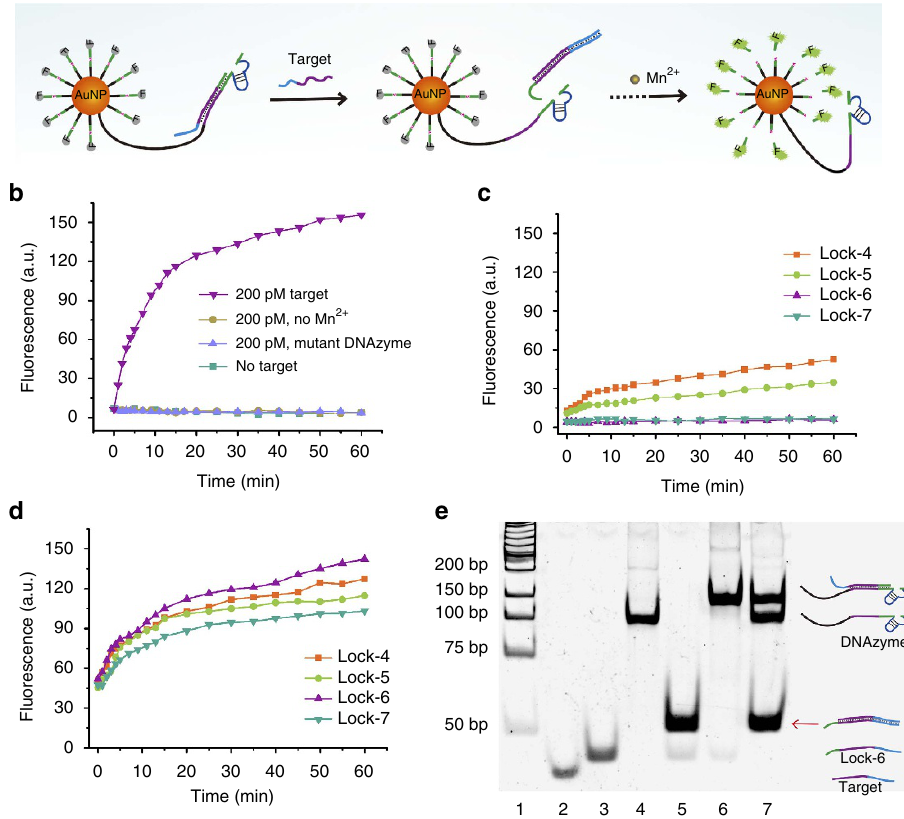
Figure 2 | Evaluation of a DNAzyme motor for its performance in solution. ( a ) Operation of DNAzyme motor initiated by the specific nucleic acid target. ( b ) Real-time monitoring of fluorescence generated by the DNAzyme motor in response to the target sequence and cofactor Mn 2 þ . The relative s.d. (RSDs) from replicate experiments were 2.1–5.4%. ( c ) Background fluorescence generated by four motors that vary by the locking strand. RSDs were 3.5–7.2%. ( d ) Real-time monitoring of fluorescence generated by the four DNAzyme motors in response to 200pM target sequence. RSDs were 4.1–8.3%. ( e ) Gel images showing strand displacement of the DNAzyme strand by the target DNA, forming a duplex between the target and the locking strand. Lane 1: DNA ladder; lane 2: target DNA; lane 3: locking strand; lane 4: DNAzyme strand; lane 5: mixture of locking strand and target DNA at 1:1 molar ratio; lane 6: mixture of locking strand and DNAzyme strand at 1:1 molar ratio; lane 7: mixture of locking strand–DNAzyme strand complex and target DNA at 1.1:1 molar ratio. The strong band marked a red arrow corresponds to the hybrid between the locking strand and the target strand, resulting from the strand displacement